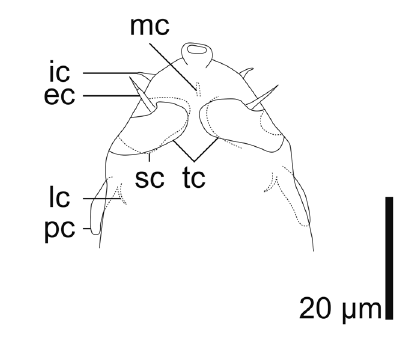
Fig. 2. Drawing of Angursa abyssalis Renaud-Mornant, 1981, cephalic region (ventral view) (USNM W